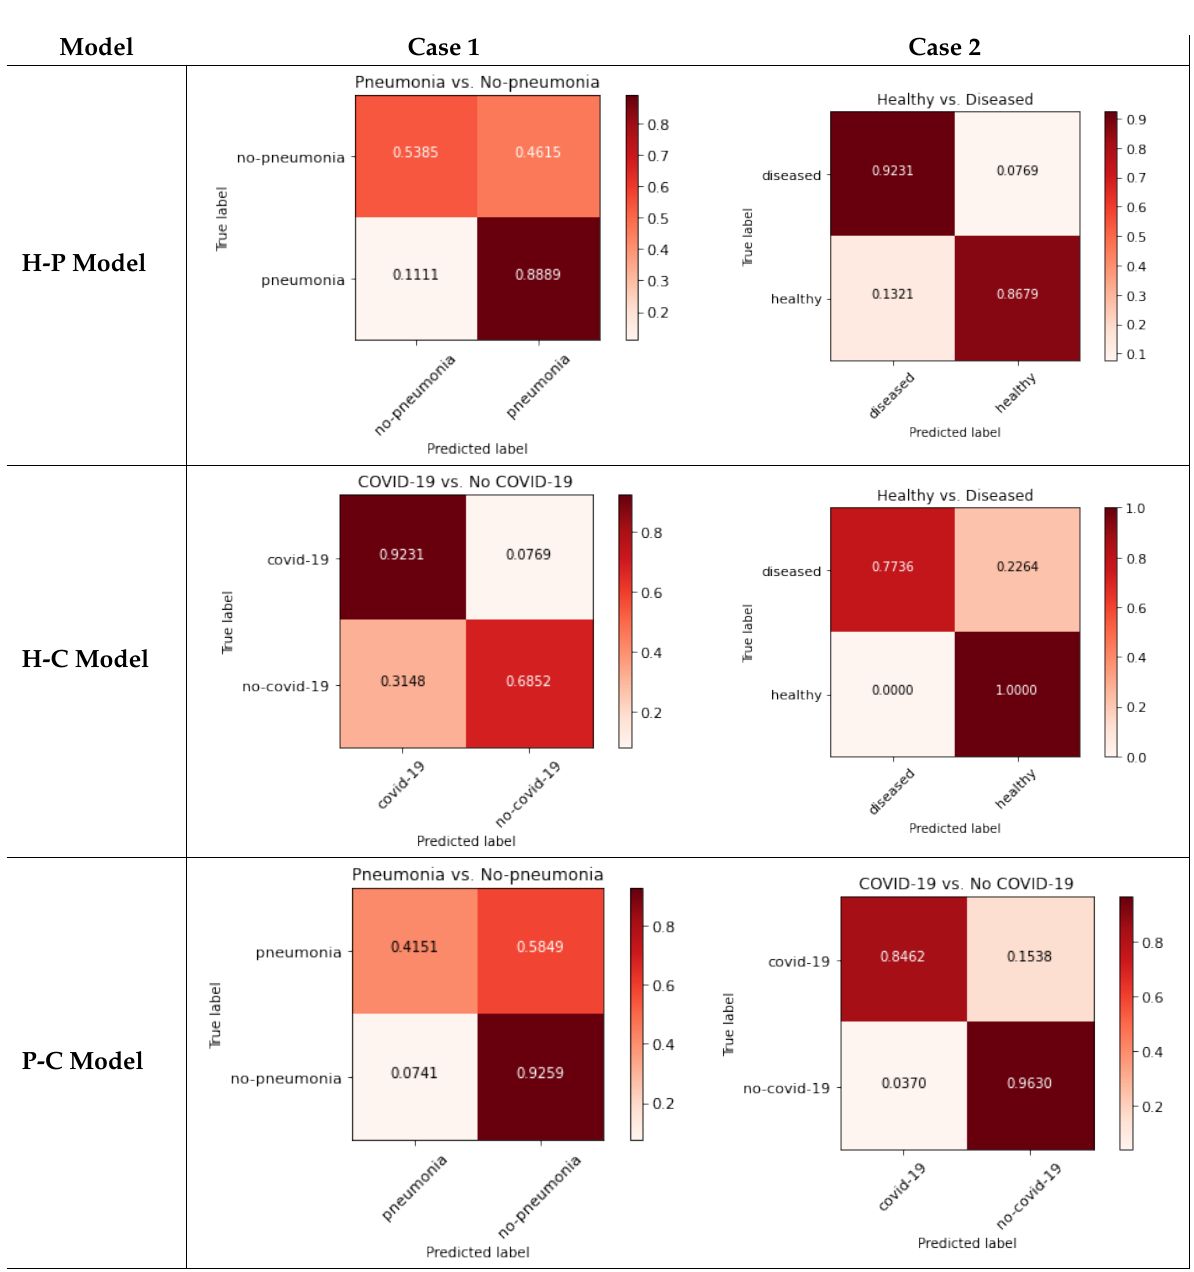
Figure 3. Pseudo confusion matrices for each